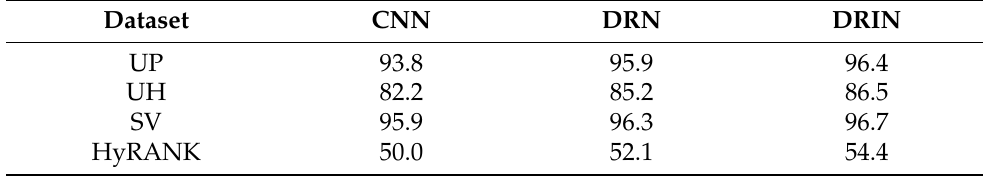
Table 14. The OA values (in %) obtained by the plain CNN, the DRN (with residual learning), and the proposed DRIN (with residual learning and involution operation) on the four benchmark